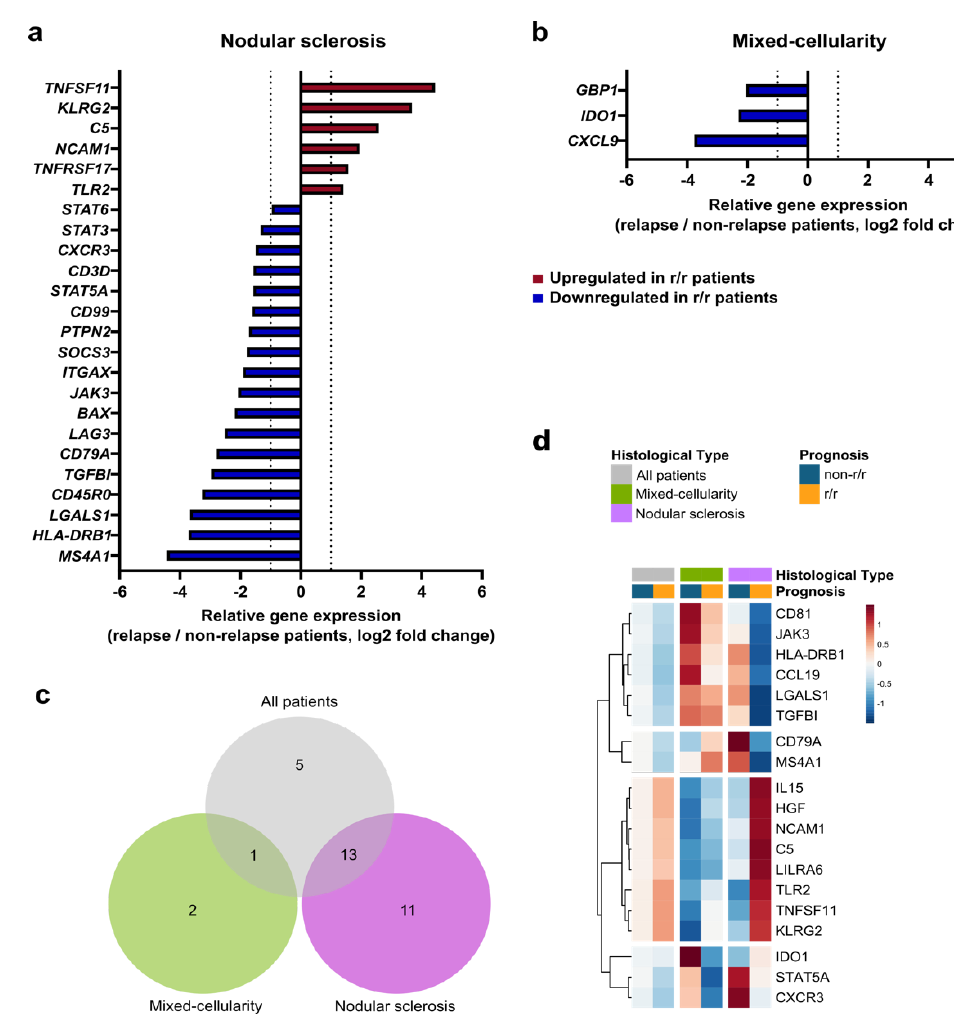
Figure 2. Immune-related gene prognostic signature according to classical Hodgkin lymphoma histological subtypes: ( a ) and ( b ) differentially expressed genes ( p -value < 0.05 and |fold change| > 2) at diagnosis in r/r compared to non-r/r patients in nodular sclerosis and mixed-cellularity subtypes, respectively; ( c ) Venn diagram showing the intersection of differentially expressed genes at diagnosis ( p -value < 0.05 and | fold change| > 2) between r/r and non-r/r patients for all cHL cases and according to the subtypes; ( d ) heatmap showing the average expression of the prognostic genes identified in Figure 1 according to r/r and non-r/r status, for all patients and for mixed-cellularity and nodular sclerosis sub-cohorts (z-score normalized counts mean).